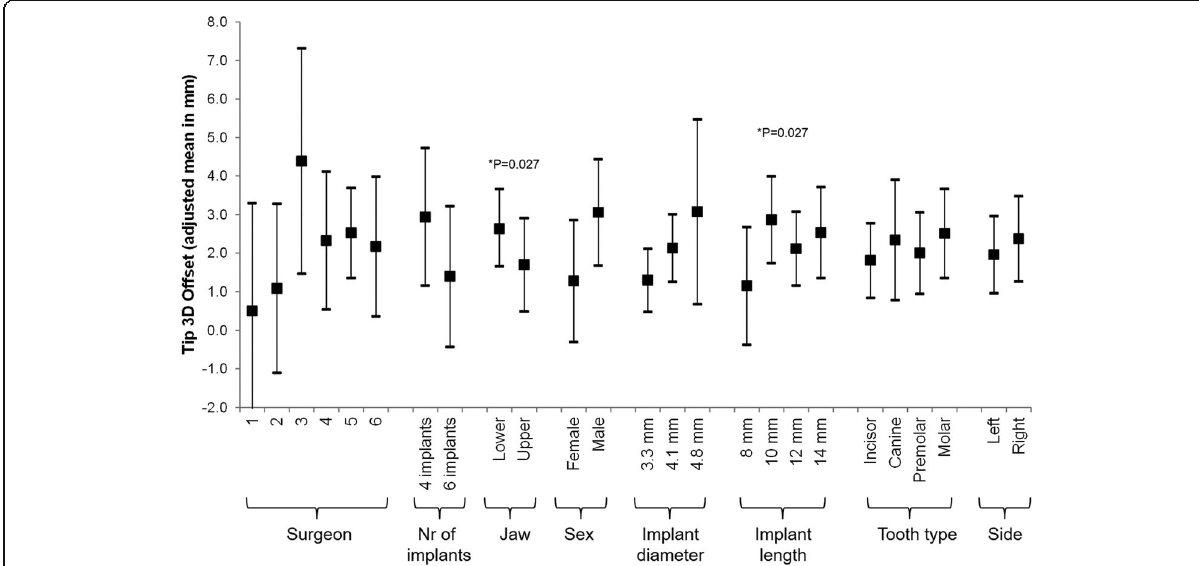
Fig. 3 Multivariable association between Tip 3D Offset and all considered risk factors. A mixed regression model was used. The effect of the patient was introduced in the model as a random effect